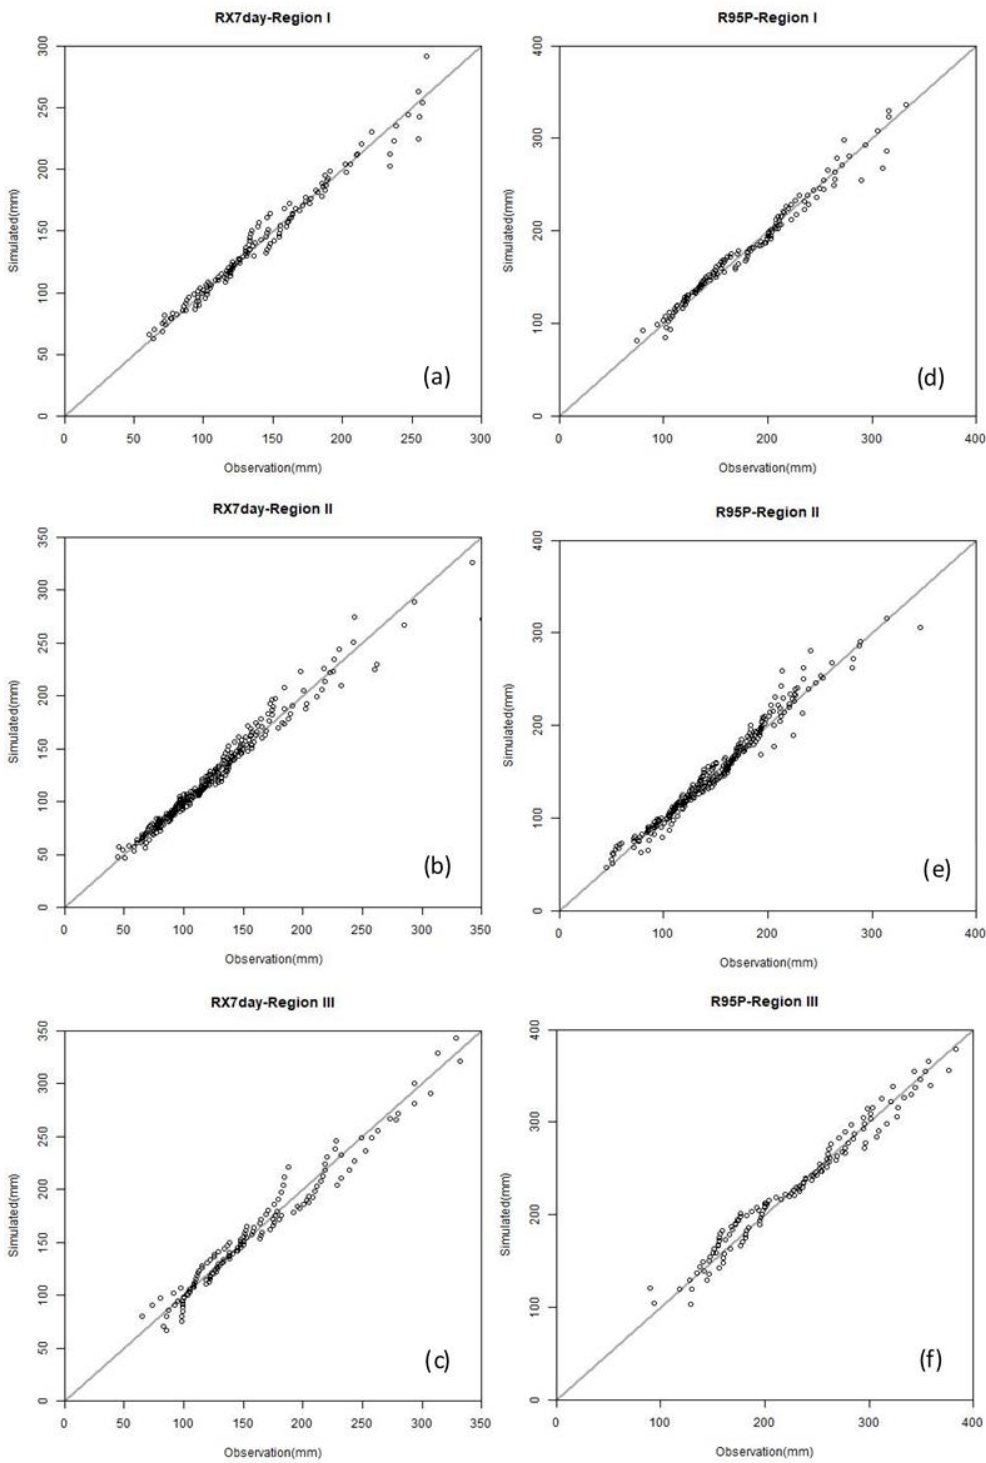
Figure 6. Observation and simulation value of precipitation extremes in each region of RX7day ( a , b , c ) and R95P ( d , e , f ) series.